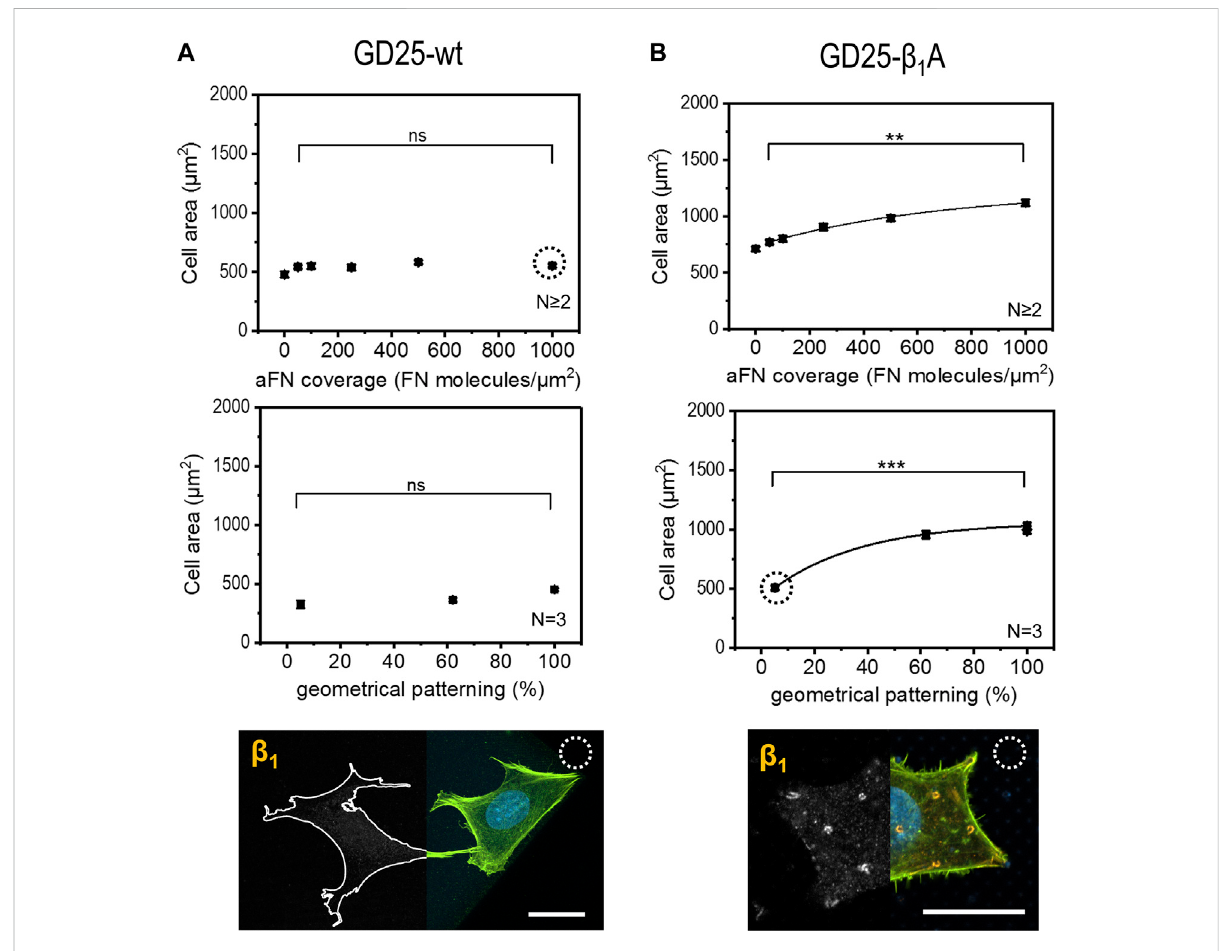
FIGURE 4 Cell area dependency on FN availability is absent in GD25-wt cells and is restored in GD25- β 1A. (A) β 1-de fi cient cells GD25-wt lack any increasing trend of spreading area, either on aFN diluted surfaces or patterns. Immunocytochemical stainings show the absence of β 1 integrins (cell contours were drawn for eye guidance). (B) GD25- β 1A cells show a restored spreading area trend, as well as β 1 clusters on patterned surfaces centrally and peripherally. Scalebar 20